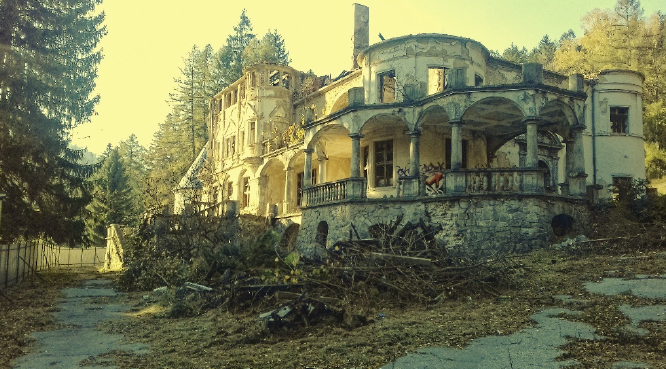
Figure 1. Terrestrial photo of the Kunerad Mansion, captured by the authors.